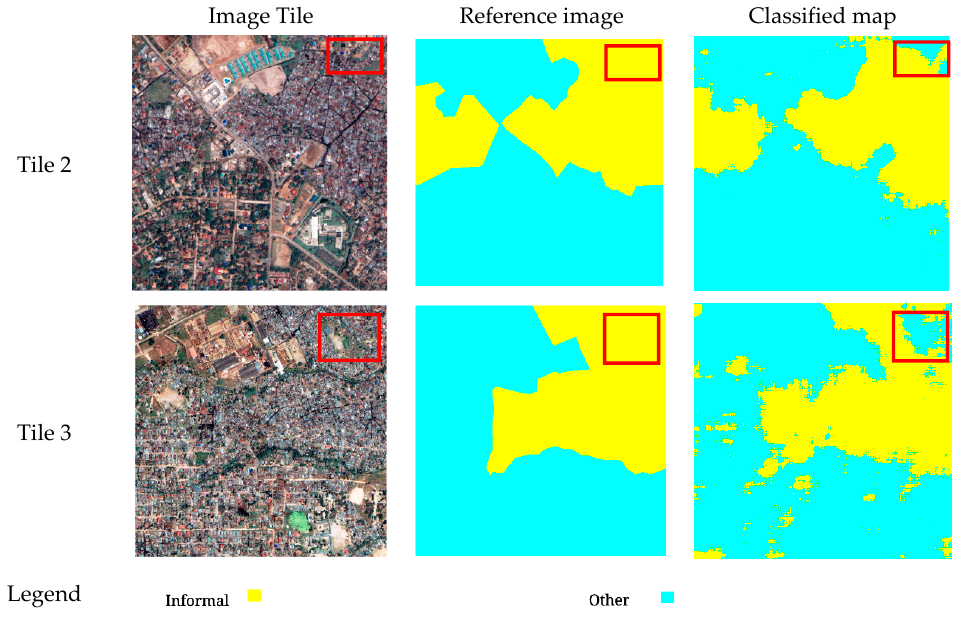
Figure 8. Red boxes highlight the northeastern part of tiles 1 and 2 where misclassification occur.